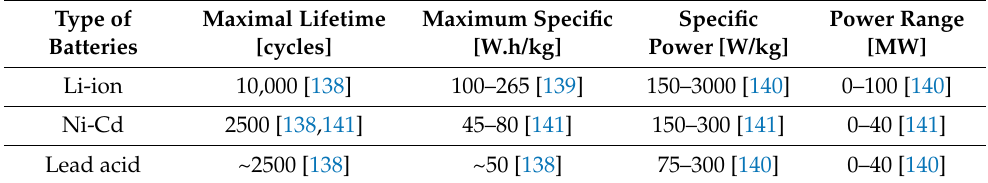
Table 10. Technical data analysis of different batteries for